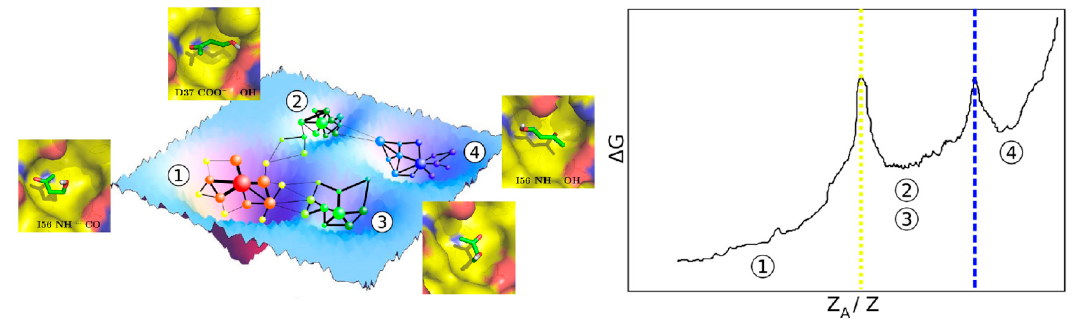
Figure 2. Exhaustive sampling of solvent-protein configurational space enables quantification of binding free energies. The figure is taken from [58].